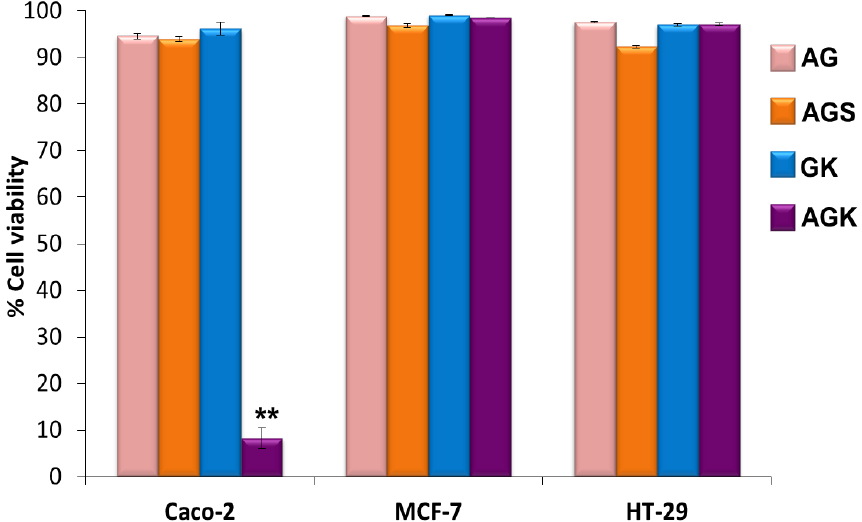
Figure 5. Investigation of the specificity of AGK against colon and breast cancer cells. AGK selectively targets and kill cells that express PHB on the cell surface. Adapted from Sibuyi et al. [10]. Abbreviations: AG — cAuNPs + AHP, AGS — cAuNPs + AHP + non-specific peptide, GC — cAuNPs + KLA, AGK — cAuNPs + AHP + KLA. ** The difference is statistical significance at p < 0.001 for Caco-2 cells treated with AGK when compared to MCF-7 and HT-29 cells. Adapted from Sibuyi et al.